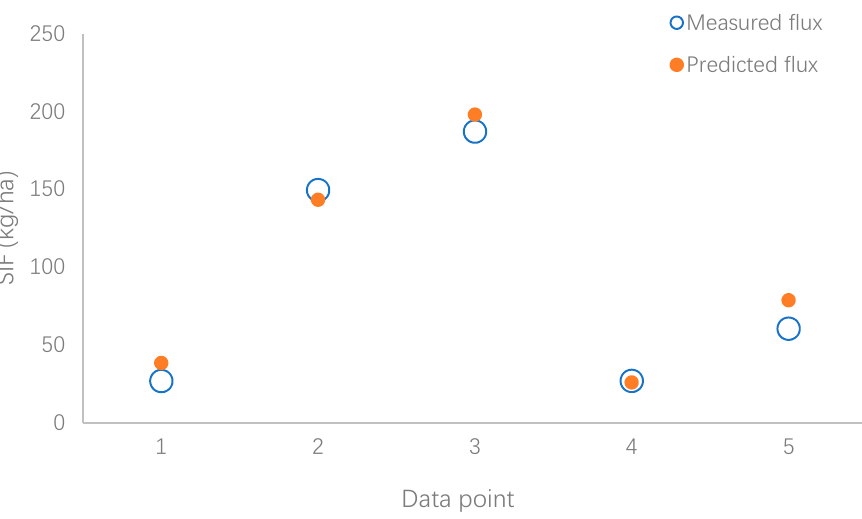
Figure 7. Performance of the ANN model in simulating the methane emissions from the five independent data sets not used for training and testing of the model.